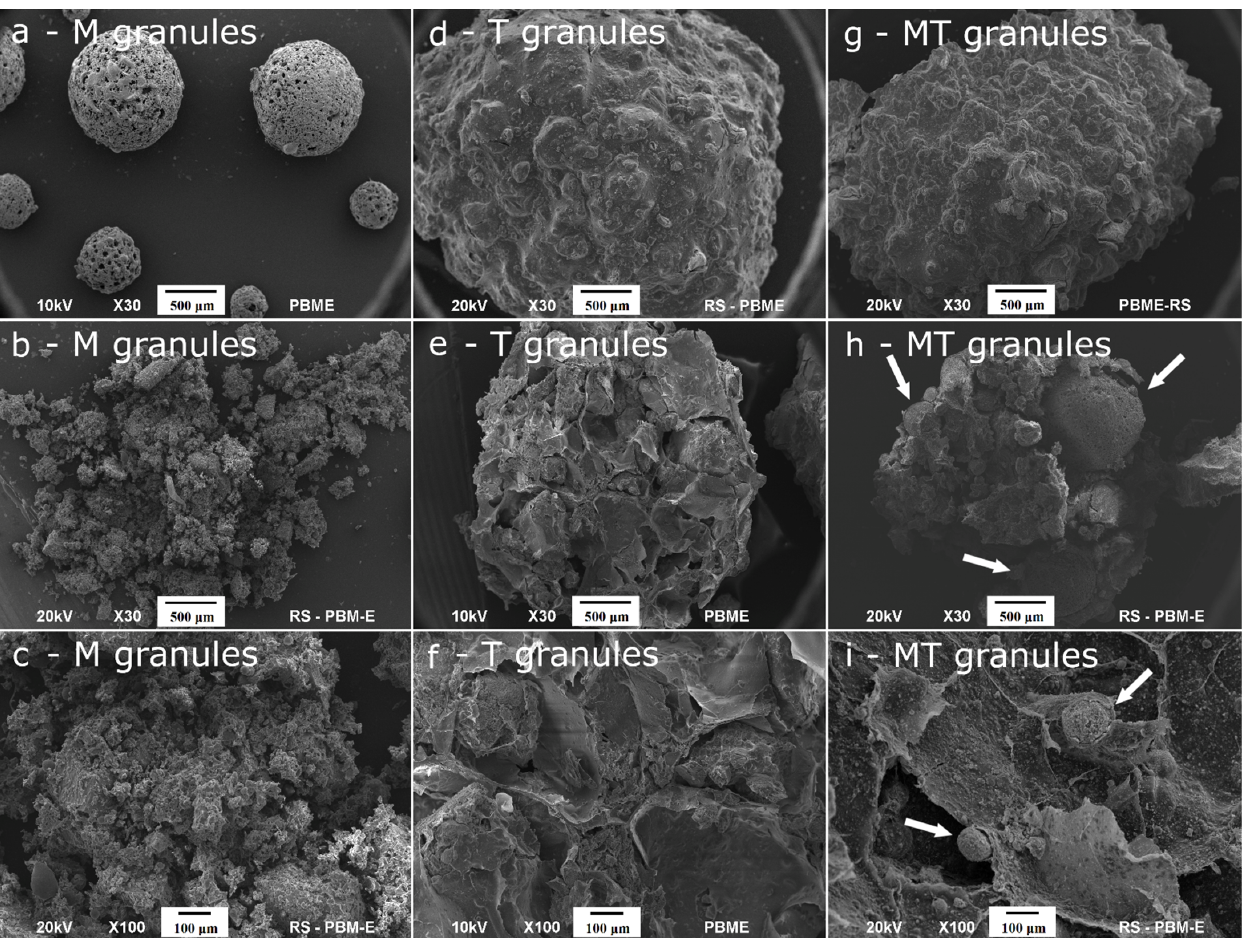
Figure 2. Representative SEM images of the samples: ceramic microgranules (AgM and GaM) ( a – c ); composite granules (AgT and GaT) ( d – f ); composite granules AgMT and GaMT ( g – i